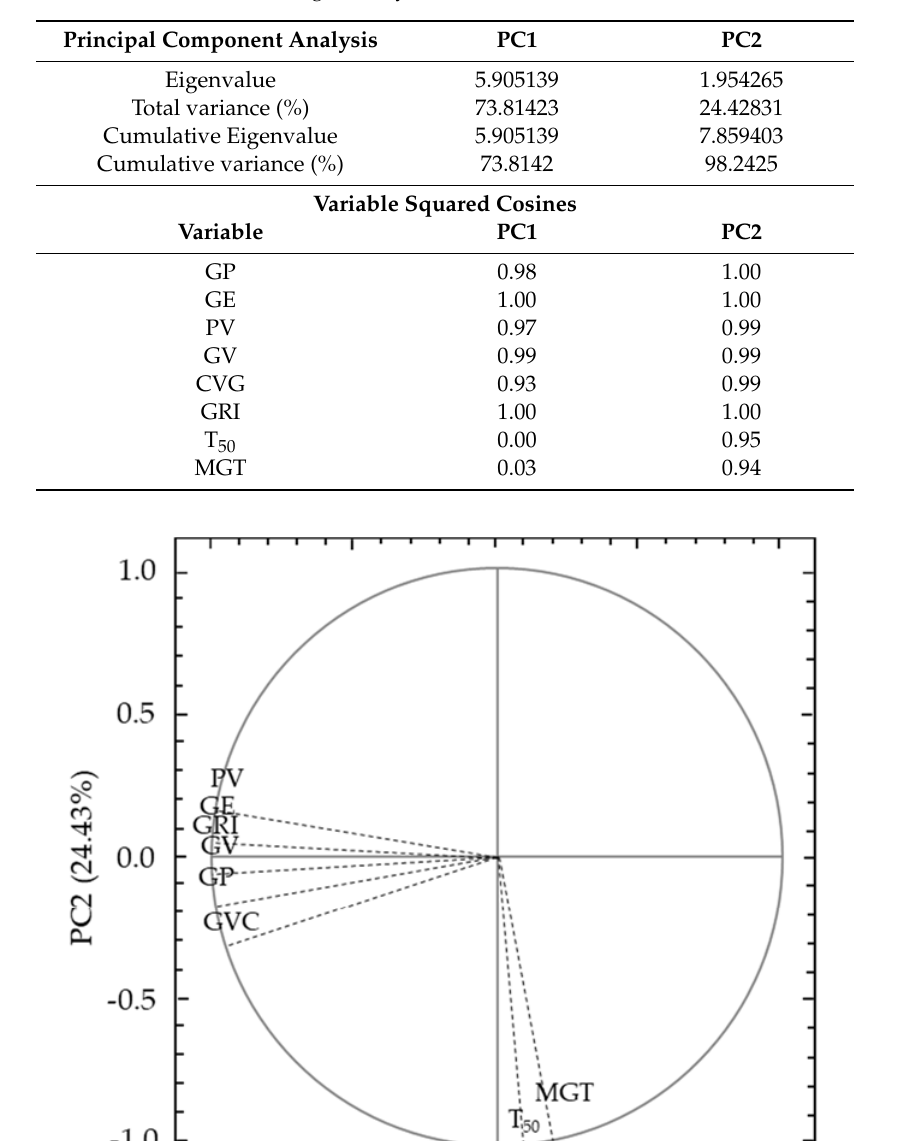
Table 2. Eigen analysis of the correlation matrix.